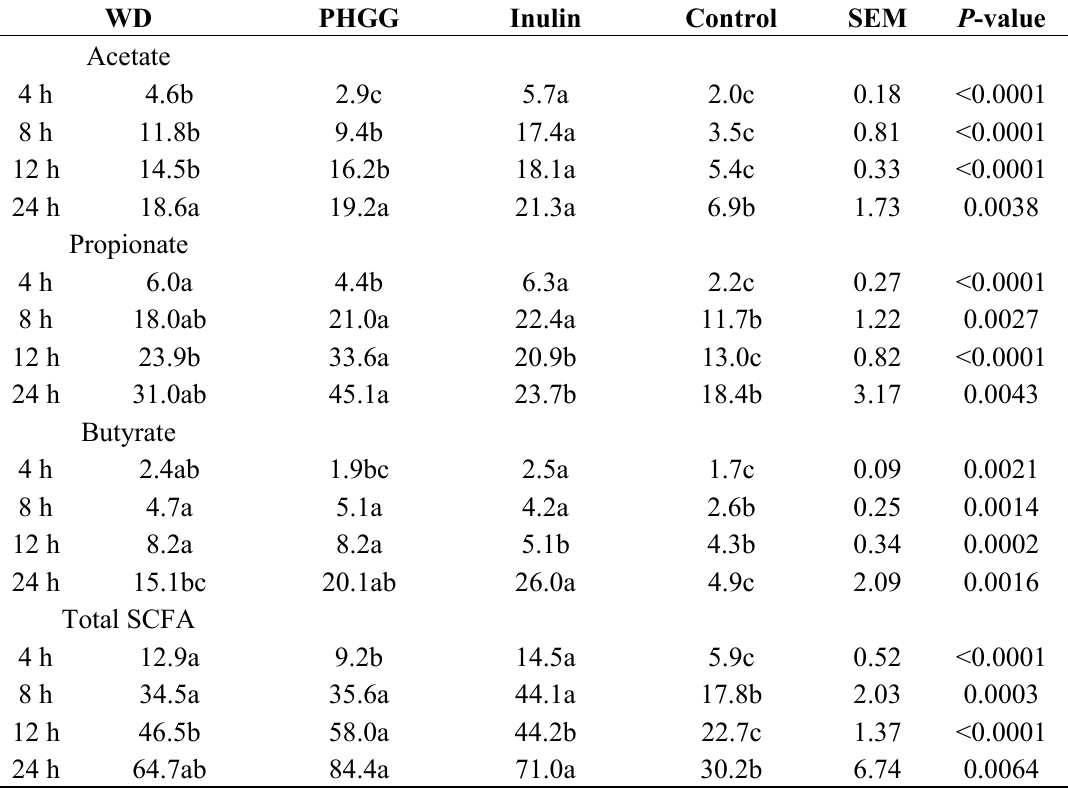
Table 2. Short chain fatty acid (SCFA) concentrations